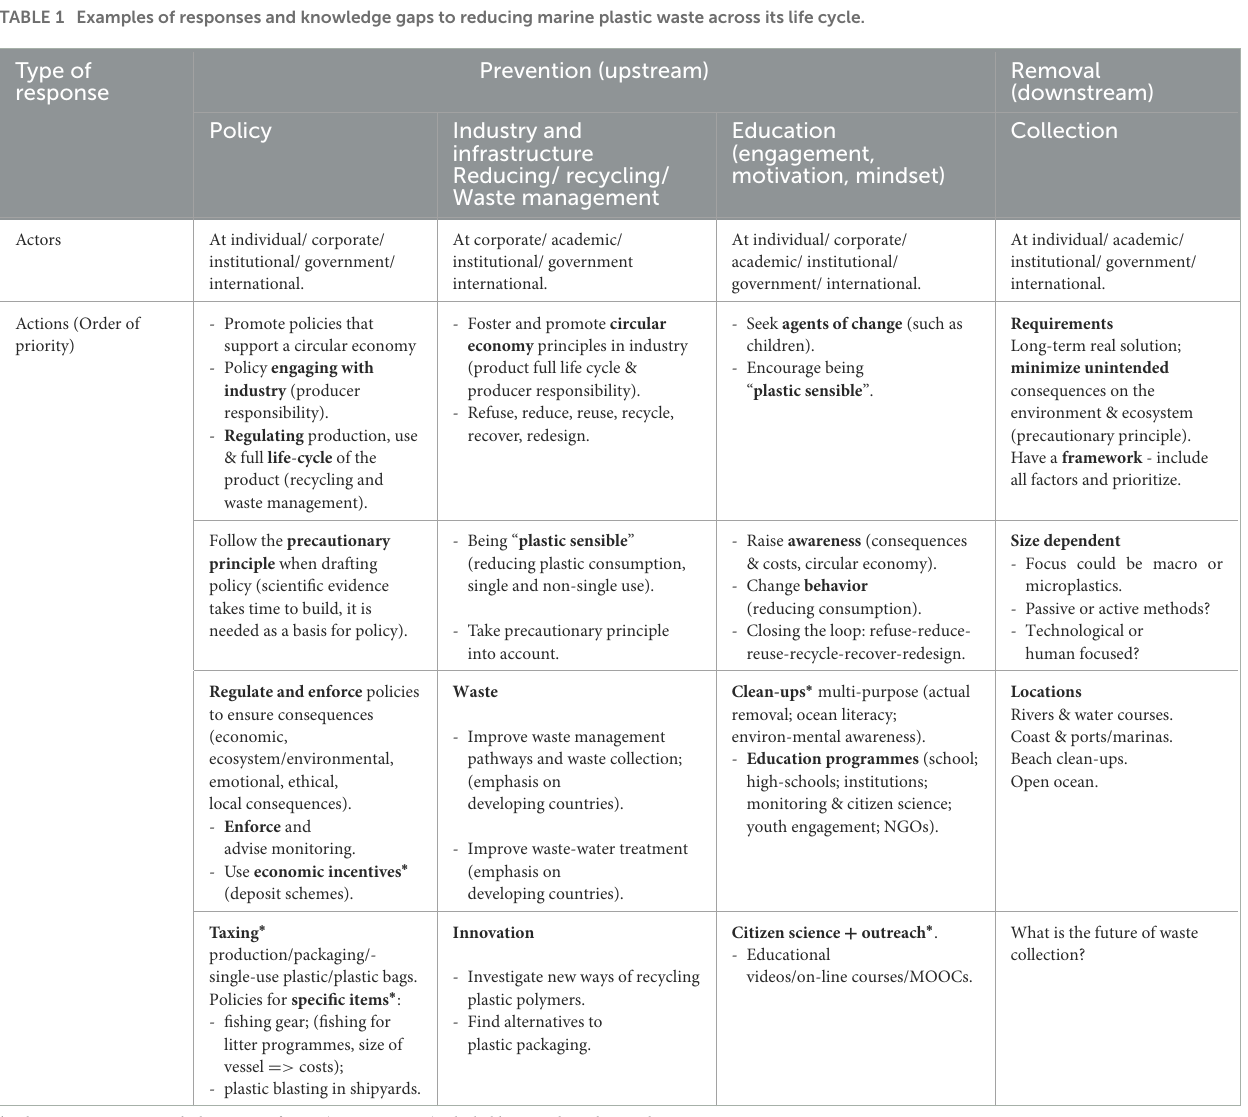
TABLE 1 Examples of responses and knowledge gaps to reducing marine plastic waste across its life